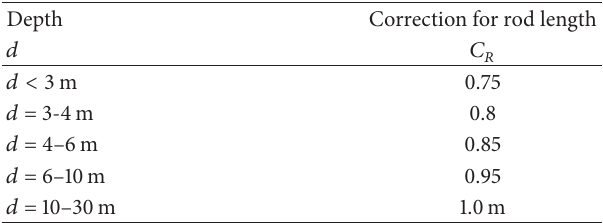
Table 3: The rod length correction with respect to the